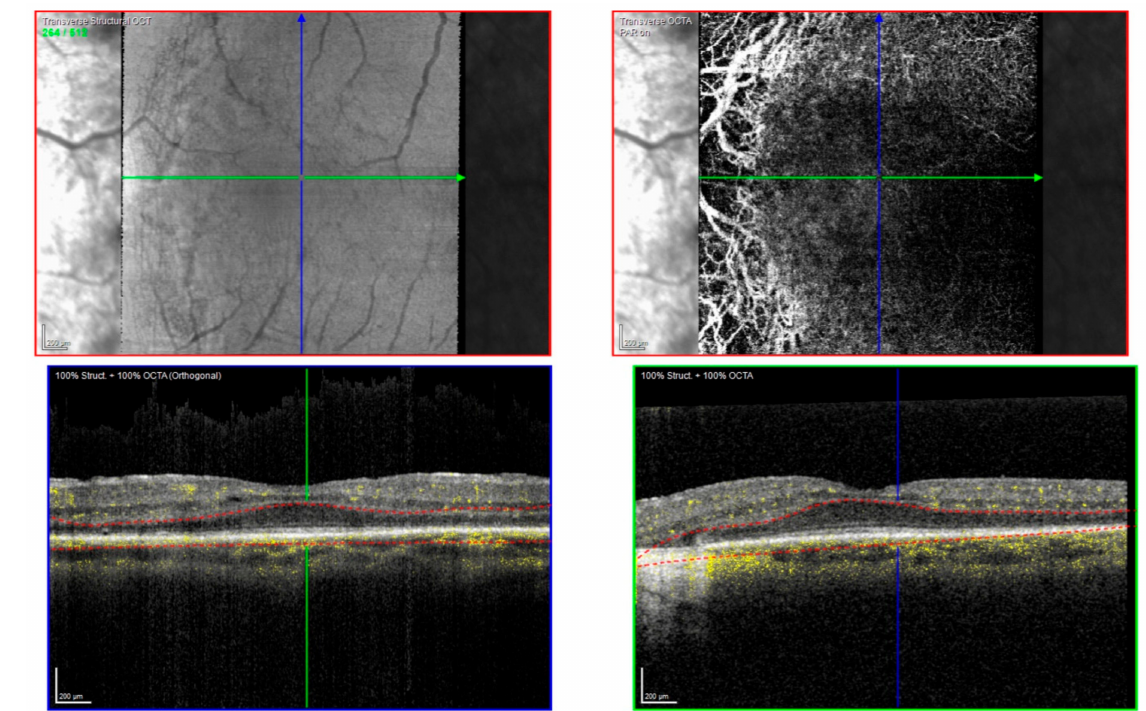
Figure 6. OCT-angiography on the left eye of patient IV:2 from family BD 35 with OCT-C-Scan (upper left), OCT angiography (upper right) and corresponding OCT-B-Scans below. Marked choriocapillaris and choroidal vessel atrophy is present in the atrophic areas.